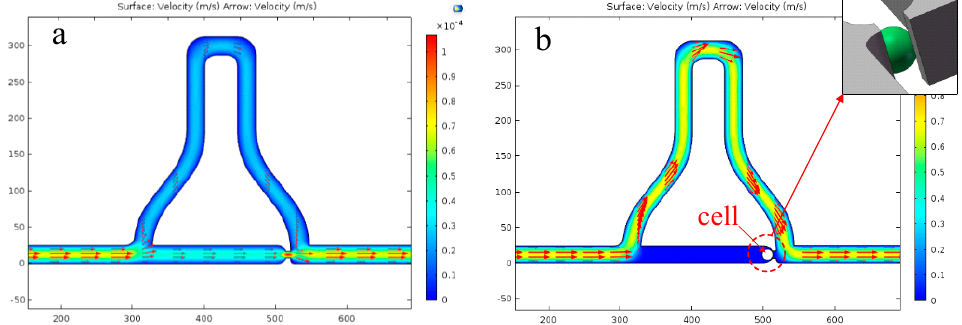
Figure 2. The flow rate distribution of microchannel before and after one-unit single cell be captured. ( a ) The volume rate of the straight channel is greater than that of the curved channel ( Q 1 / Q 2 > 1). ( b ) The rate distribution changed after one-unit single cell is captured ( Q 1 / Q 2 < 1). As shown in the detail figure, a cell is considered as an uncompressible solid sphere. Thus, the trap site is not completely blocked after the cell is captured, and the volume rate, Q 1 , decreases sharply, but is not zero.